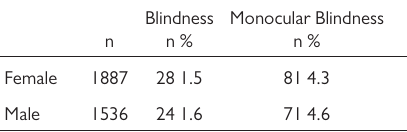
Table 2. The frequency of blindness and monoc- ular blindness in gender